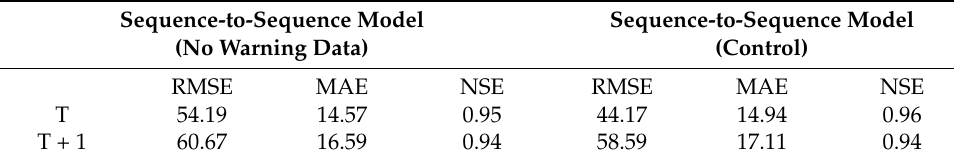
Table 14. Prediction accuracy results after excluding warning data.